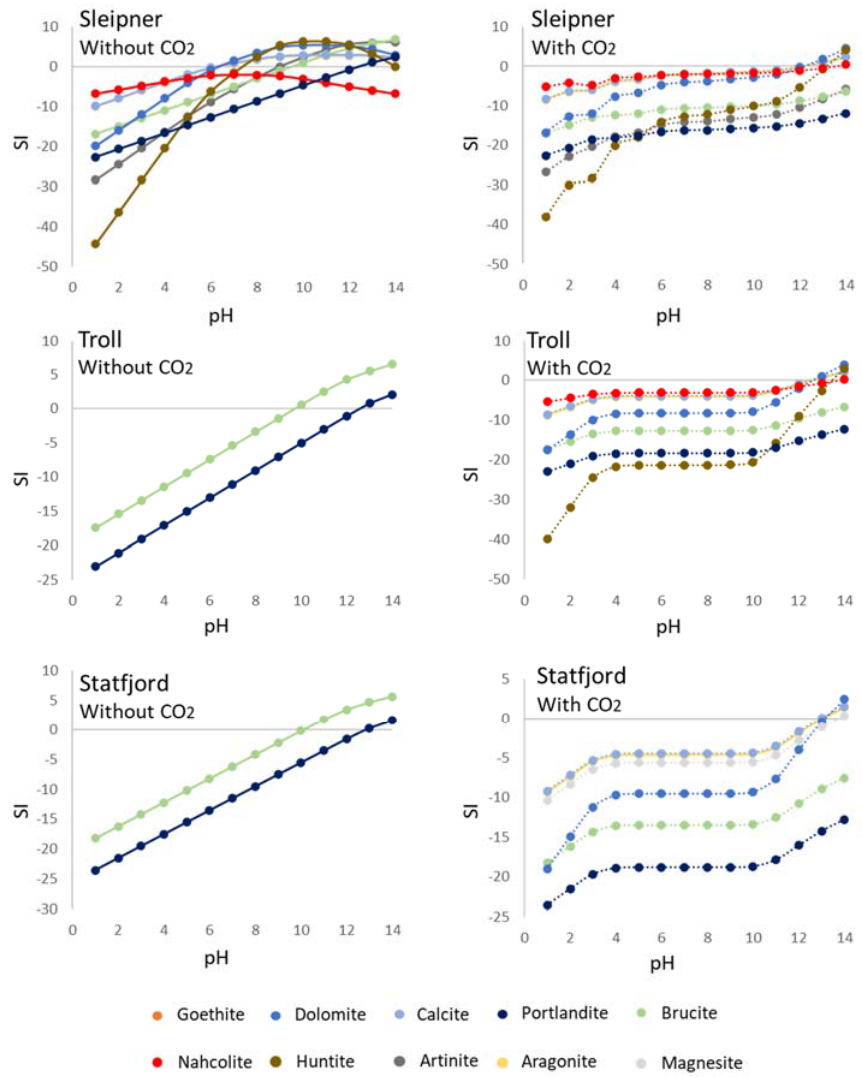
Figure 3. Modelled saturation indices (SI) for Sleipner, Troll and Statfjord formation waters at 23 °C and 1 atm for different pH values, without ( left ) and with ( right ) additional CO 2 . The aragonite phase coincides with calcite.